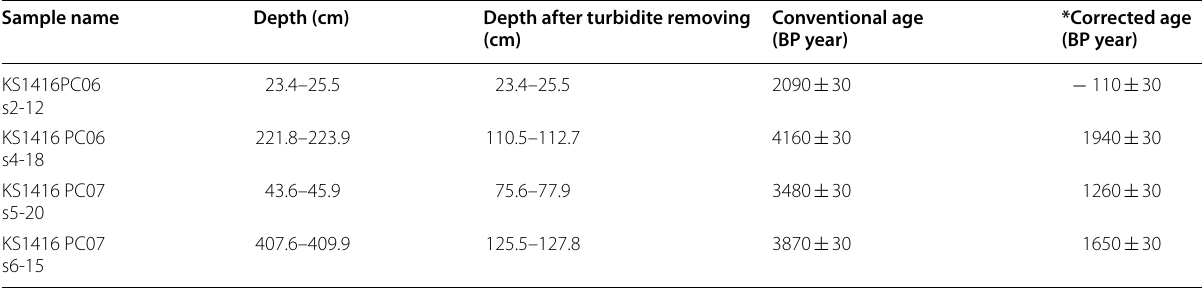
*Corrected age, taking into account the 2200 years